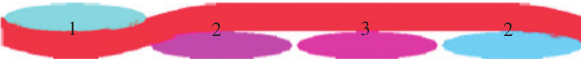
Figure 6: Cross-sectional pattern of the RVE.